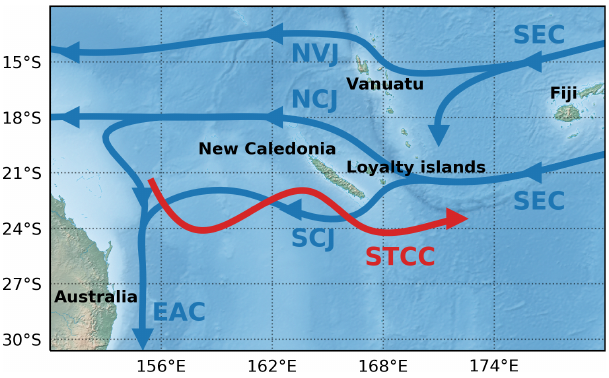
Figure 1. Geography and circulation around New Caledonia re- produced from Cravatte et al. (2015), with the names of islands (black names), thermocline currents (blue curves and names) and surface currents (red curves and names). Indicated are the SEC (South Equatorial Current), NVJ (North Vanuatu Jet), NCJ and SCJ (North and South Caledonian jets), STCC (Subtropical Countercur- rent) and EAC (East Australian